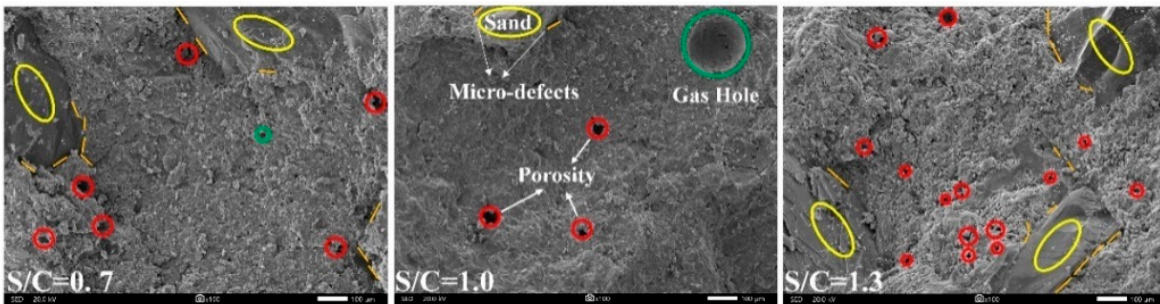
Figure 8. Microstructure of rock-like materials with different SCR.